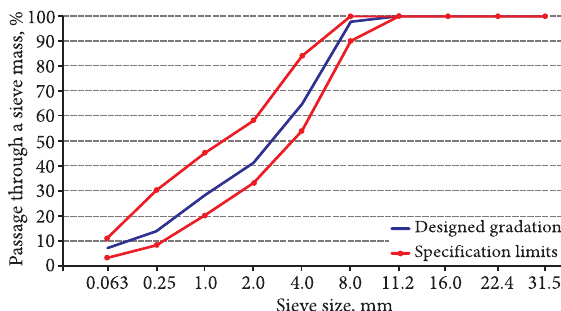
Fig. 2. Gradation of asphalt